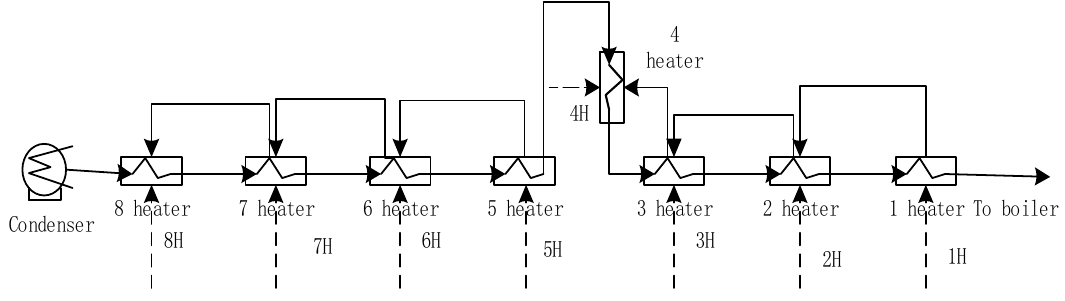
Figure 2. Flow chart of return water heating.